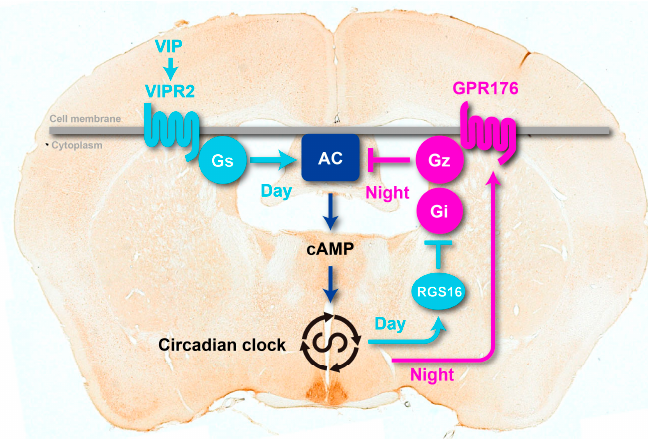
Figure 3. A model of circadian GPCR-cAMP signaling in the SCN. The orphan receptor GPR176 couples to G z and thereby antagonizes the VIP-VIPR2-G s -mediated cAMP signaling that controls the intracellular circadian clock. The clock enhances expression of GPR176 at night and represses it during the day. At the beginning of the day, the clock induces expression of RGS16, which deactivates the cAMP-repressive signal through G i and perhaps G z . This helps increasing cAMP synthesis at the start of the day. AC, adenylate cyclase. The photograph behind the schematic model is a representative mouse coronal brain section immunolabeled for GPR176.